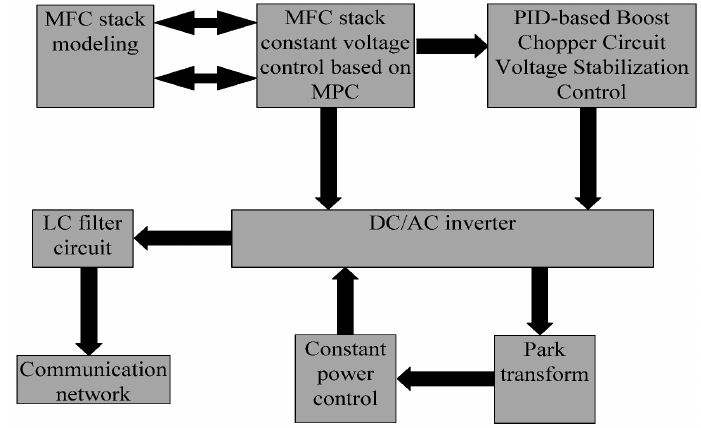
Figure 8. Flow chart of grid−connected microbial fuel cell stack control system.